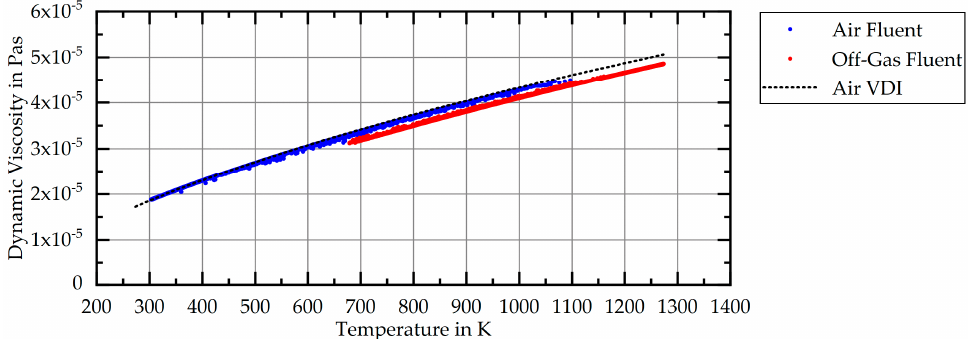
Figure A3. Sampled data points of the heat conductivity of air and off-gas at λ = 1.15 calculated in ANSYS® Fluent in comparison with values from [21].